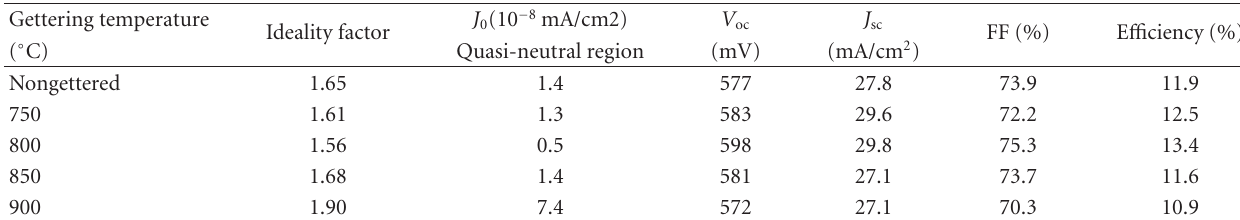
Table 1: Properties of Si heterojunction solar